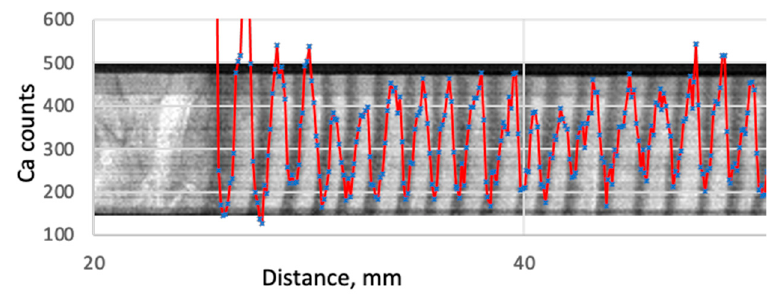
Figure 3. An exemplary fragment of an X-ray image (pine #1, east) superimposed by the graph of counts for Ca. Every blue marker denotes the horizontal distance at which the multi-scanner took the measurement. The horizontal span between the points is 100 µm. The vertical height of the points is the number of counts for Ca. The red line connects the markers for visibility.